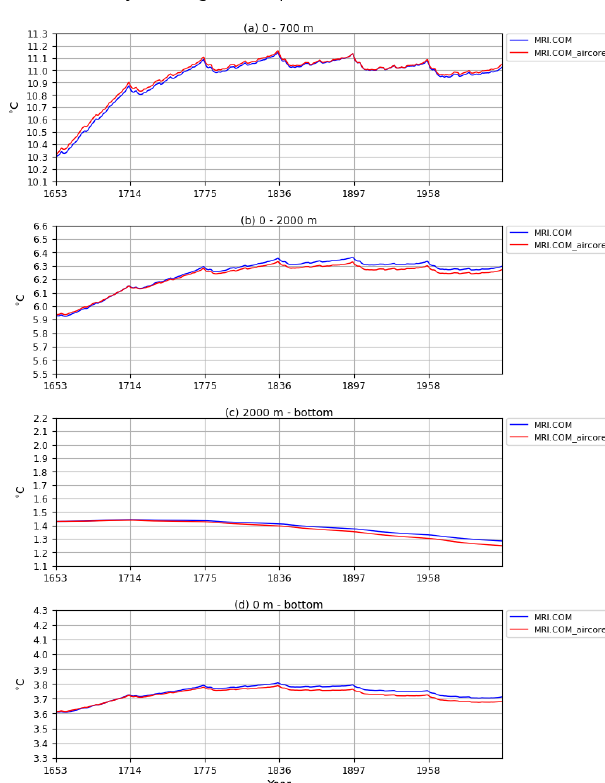
Figure B3. Drift of annual mean, global mean vertically aver- aged temperatures ( ◦ C) for four depth ranges: (a) 0–700m, (b) 0– 2000m, (c) 2000m–bottom, and (d) 0m–bottom of two OMIP- 2 simulations by MRI.COM differing in the set of formulae for properties of moist air used to compute surface turbulent fluxes. Gill (1982) (blue) and Large and Yeager (2004, 2009) (red).